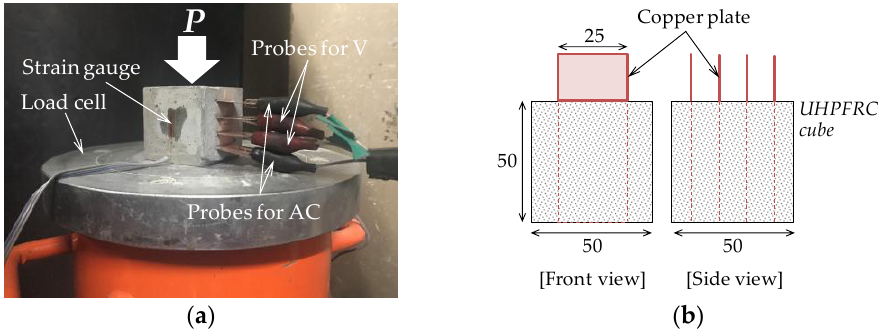
Figure 2. Test setup for compressive test: ( a ) test picture; and ( b ) geometrical details of cube.